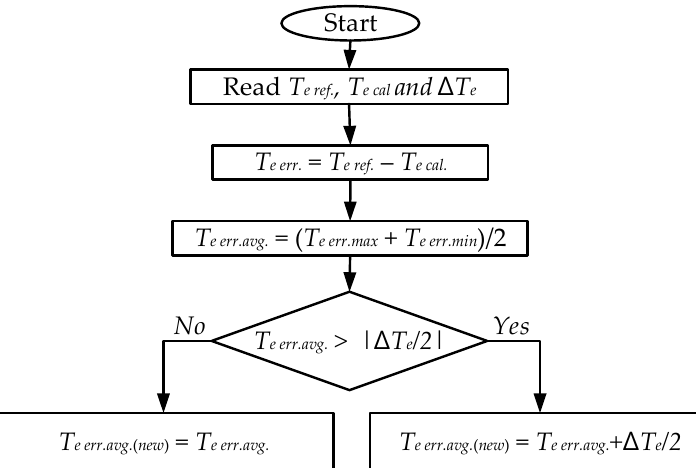
Figure 9. Proposed torque capability improvement algorithm.